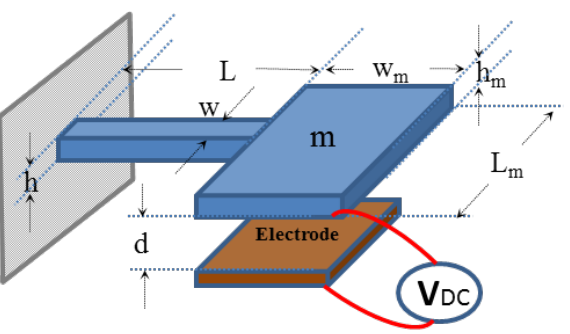
Figure 13. Schematic of the proposed switch.